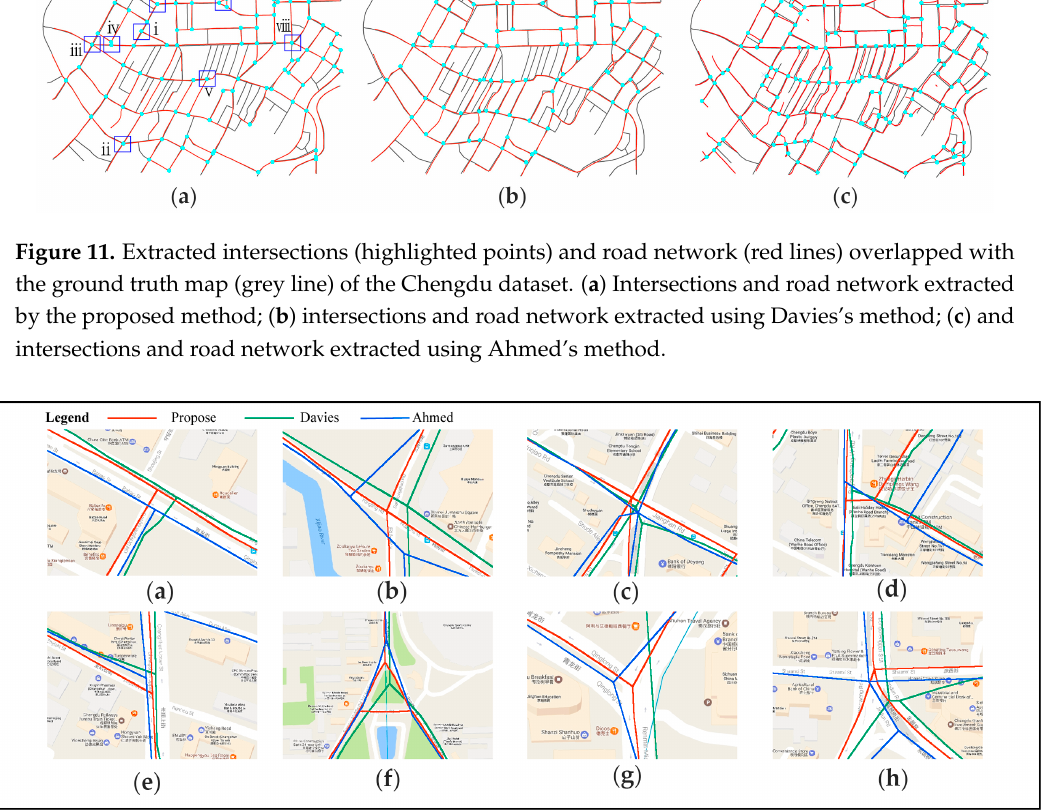
Figure 12. Comparisons of the detailed intersection results obtained by the various methods employing the Chengdu dataset. Figure ( a – h ) correspond to i to viii in Figure 11a.